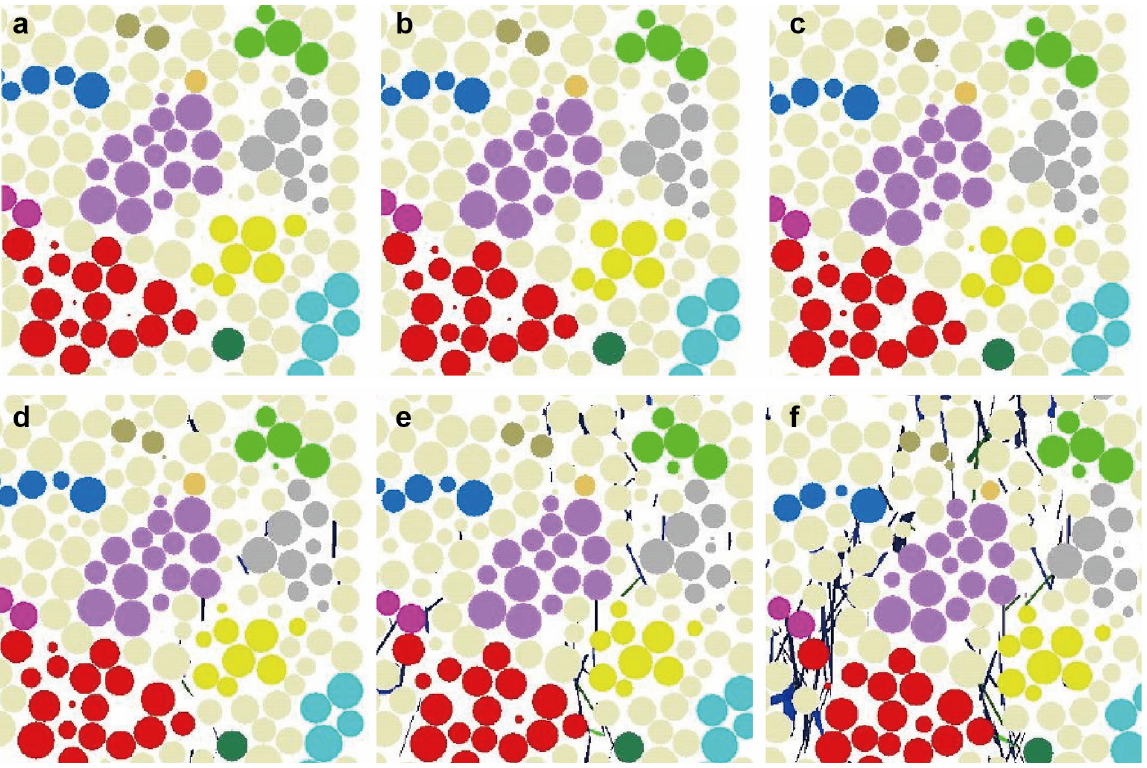
Fig. 20 Illustration of rock translation and rotation (Panels a – f refer to 40% peak load, 70% peak load, peak load, 70% post-peak load, 40% post-peak load, and 20% post-peak load,